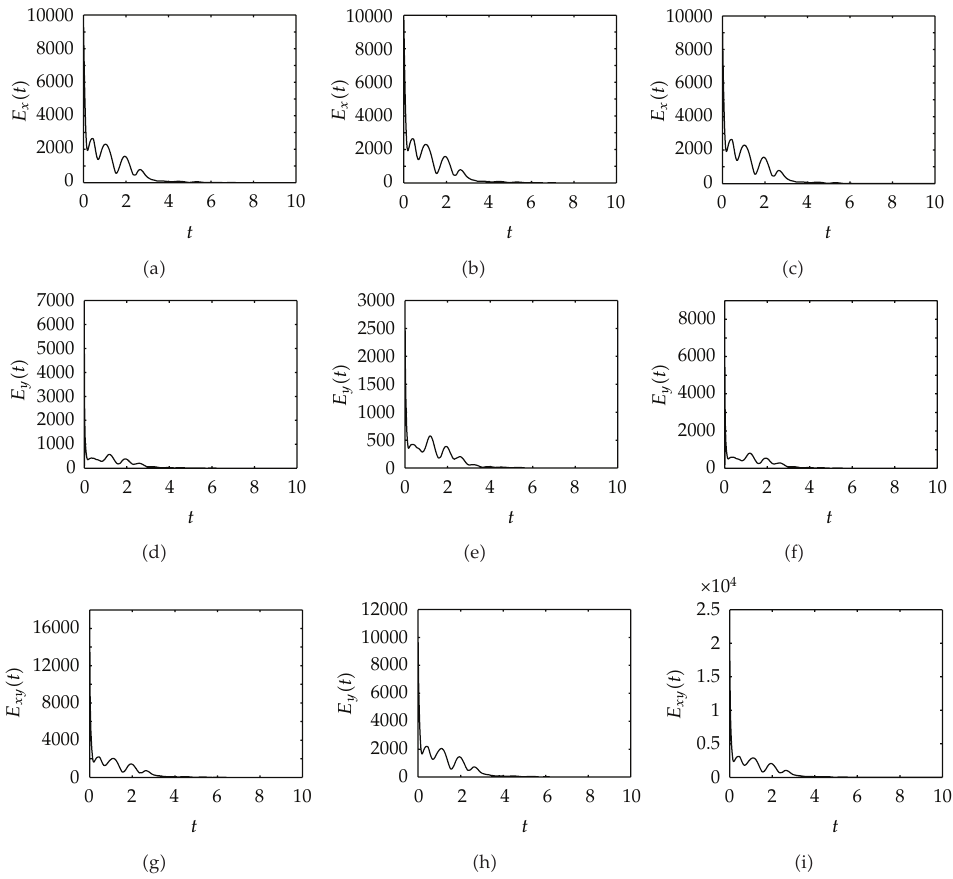
Figure 2: The change process of E x , E y , and E xy as time t → ∞ for di ff erent projective